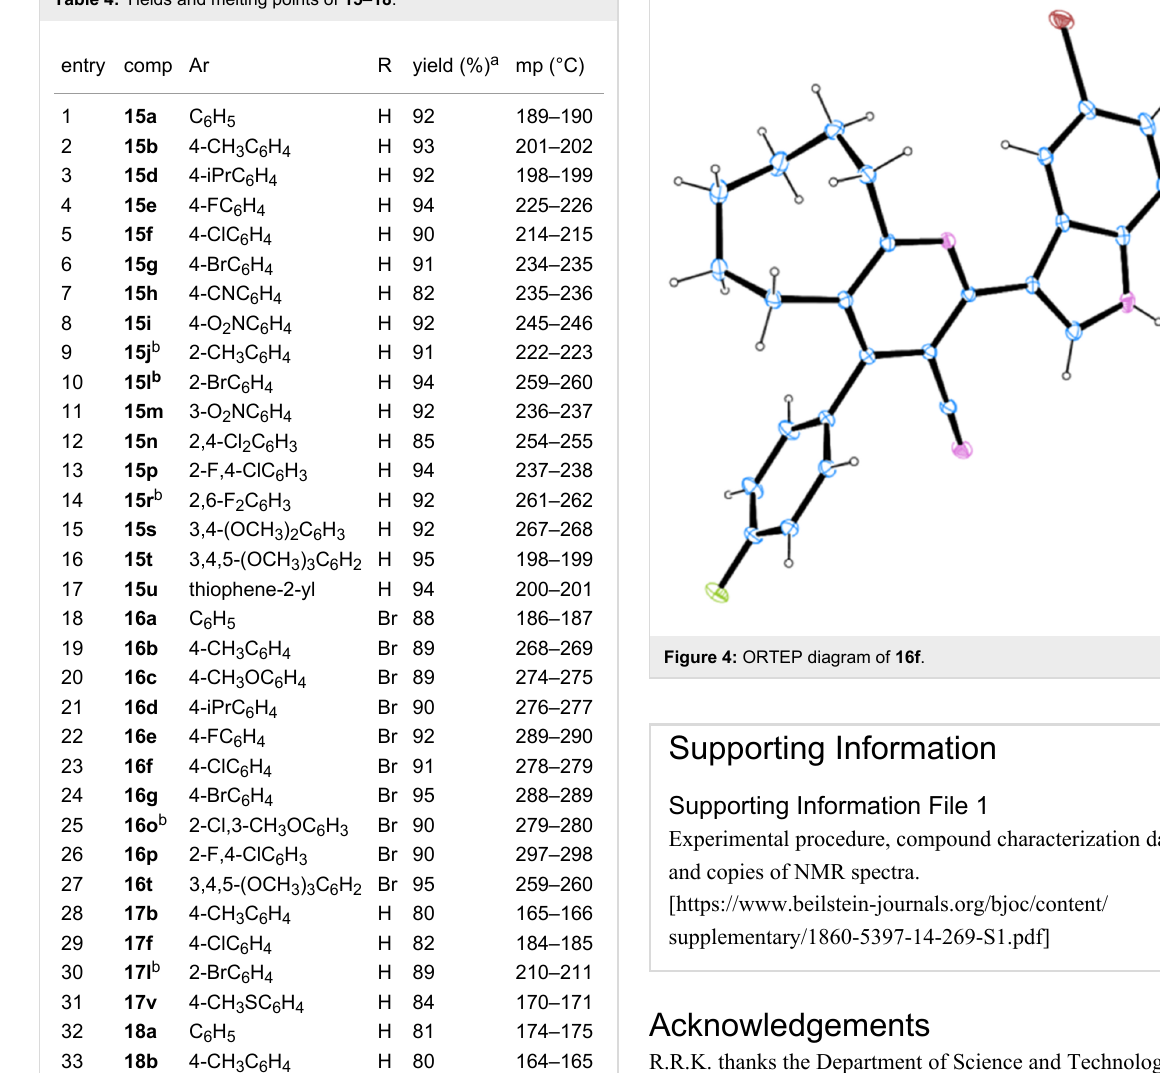
Table 4: Yields and melting points of 15 – 18 .